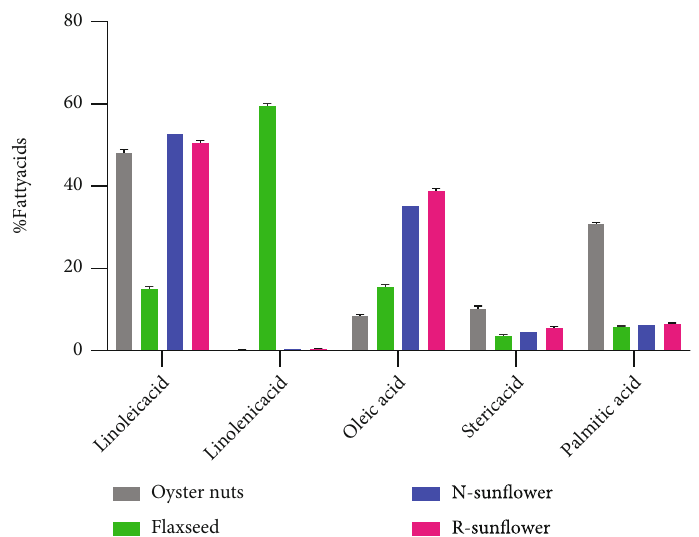
Figure 1: Bar graphs showing variations in average contents of the major fatty acid contents (%) in oyster nut oil, fl axseed oil, re fi ned sun fl ower oil, and nonre fi ned sun fl ower